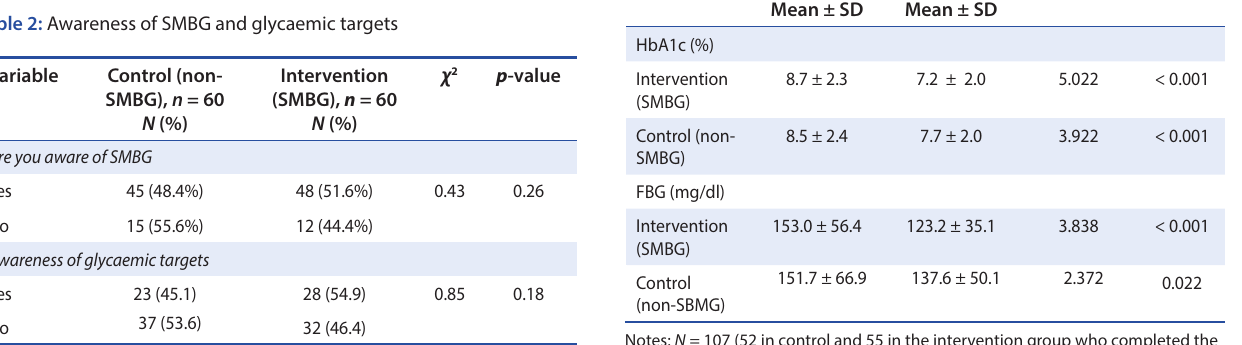
Notes: N = 107 (52 in control and 55 in the intervention group who completed the